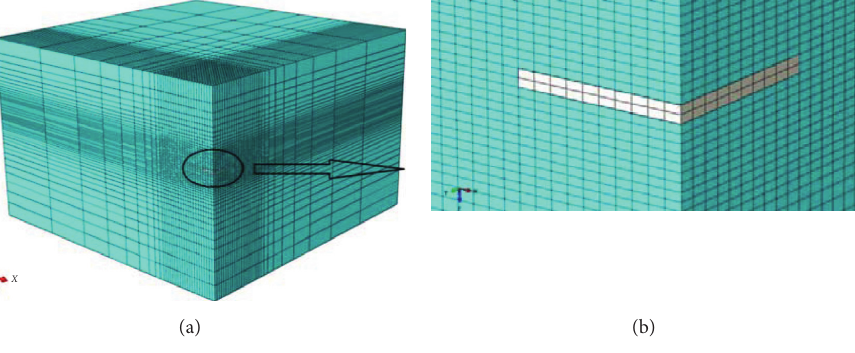
Figure 1: Mesh layout of the analysis model.